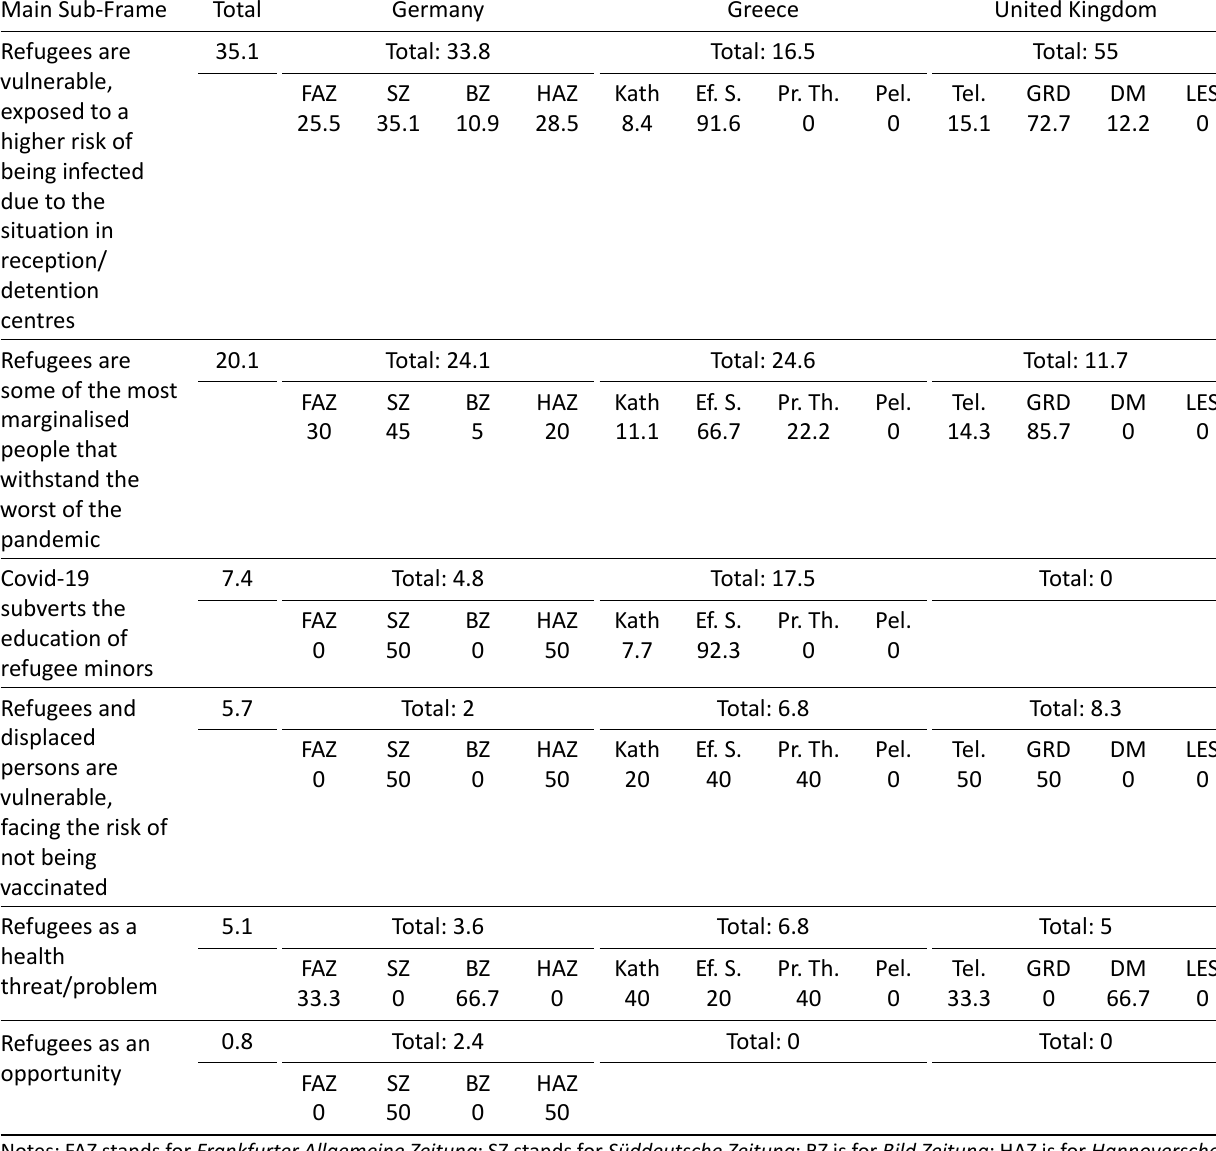
Table 2. Main sub‐frames of the refugees in total, per country and per newspaper, in percentage. Main